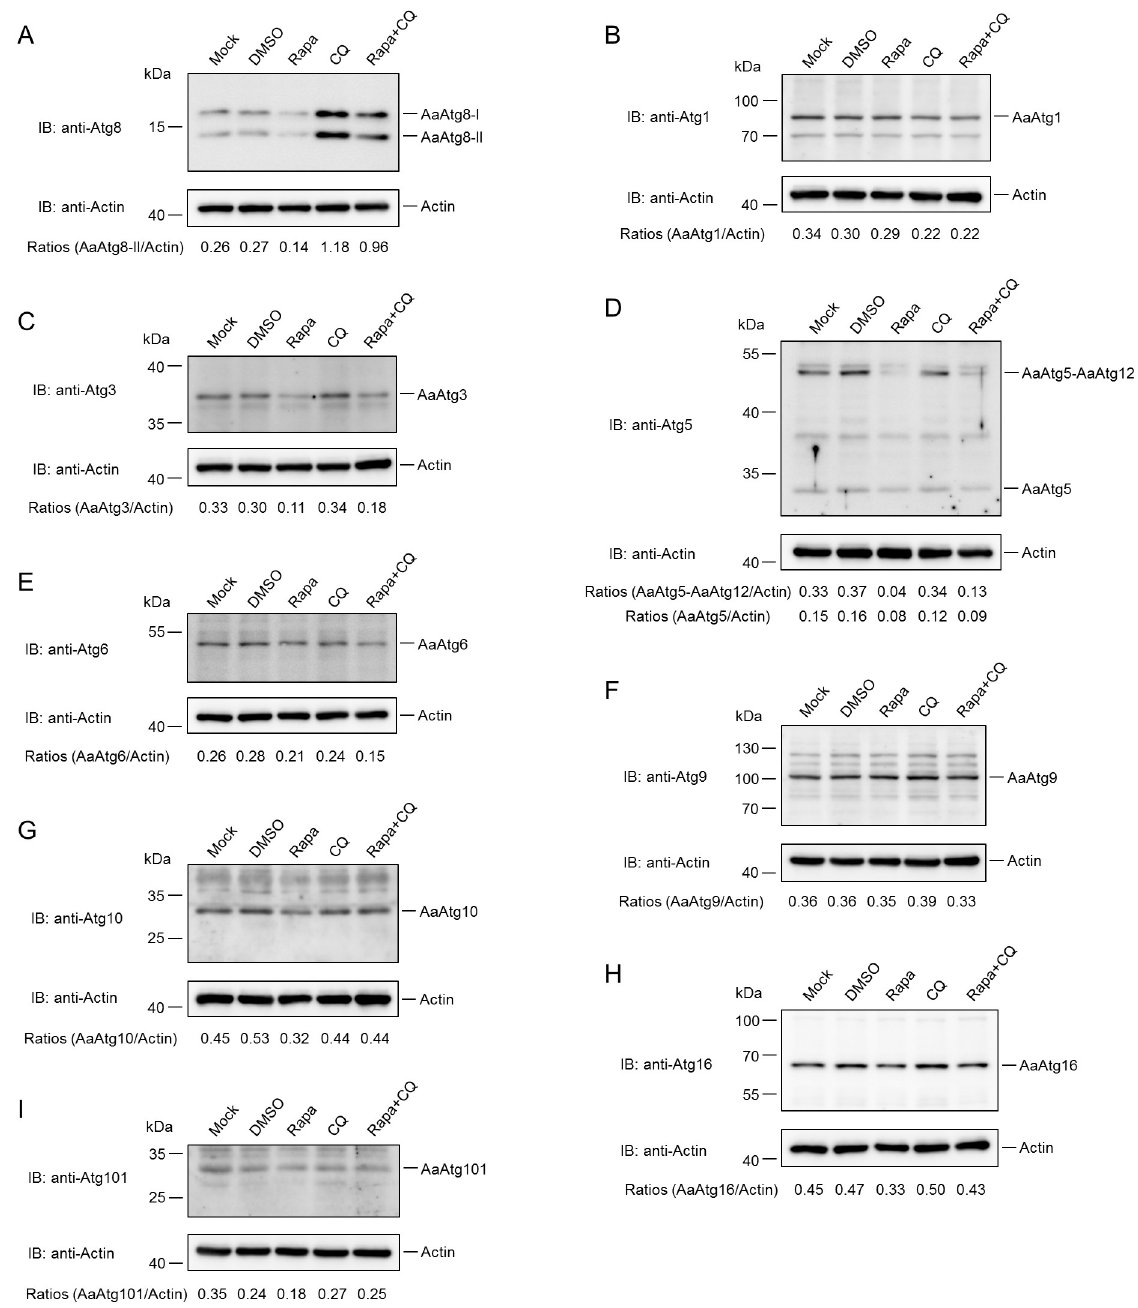
Fig 5. Responses of AaAtg proteins to autophagy Rapa. (A)—(I) C6/36 cells were treated with Rapa (500nM, dissolved in DMSO) or CQ (300 μ M, dissolved in ddH 2 O) for 24 hours and 12 hours, respectively. For Rapa plus CQ treatment, C6/36 cells were treated with Rapa for 12 hours then treated with CQ for another 12 hours. Mock treated or DMSO treated C6/36 cells were used as controls. The protein levels of AaAtg8, AaAtg1, AaAtg3, AaAtg5, AaAtg6, AaAtg9, AaAtg10, AaAtg16, AaAtg101 and actin were analysed by Western Blotting, respectively. The relative level of each AaAtg protein to that of actin was quantified by ImageJ according to materials and methods.